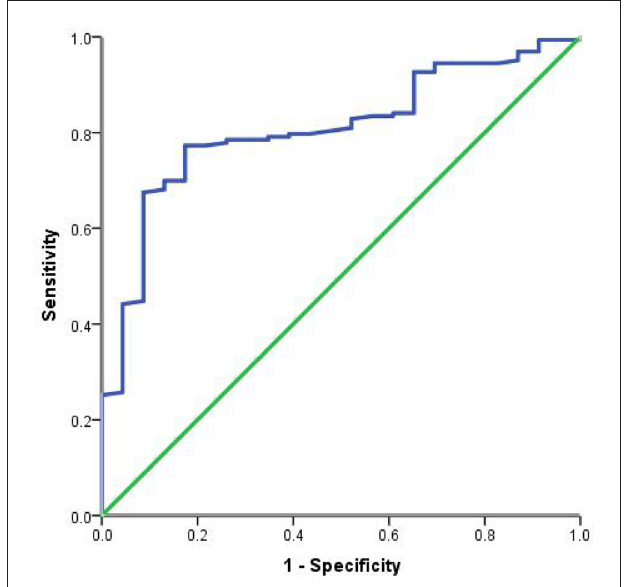
FIGURE 3 | ROC curve analysis of PLT to assess the 90-day mortality of heat stroke